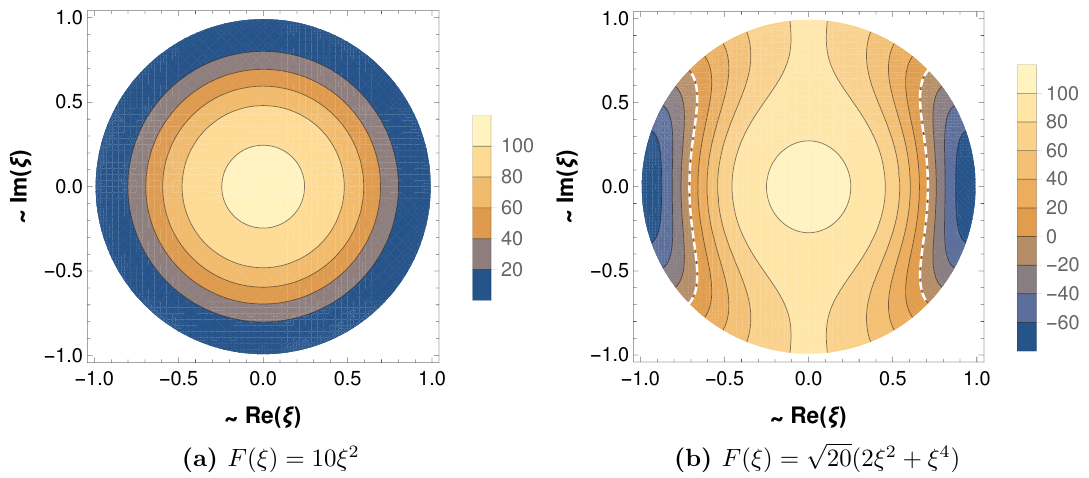
Figure 1. Contour plots of ~ g yy with ( a = 1 ; R y = 1 ; (cid:18) = 0 ; c = 100) for speci(cid:12)ed F ( (cid:24) ). Plotted on the unit disc j (cid:24) j (cid:20) 1 with radial direction rescaled to tan r . The boundaries between positive and negative domains (~ g yy = 0), if present, are separated by a dashed white line.